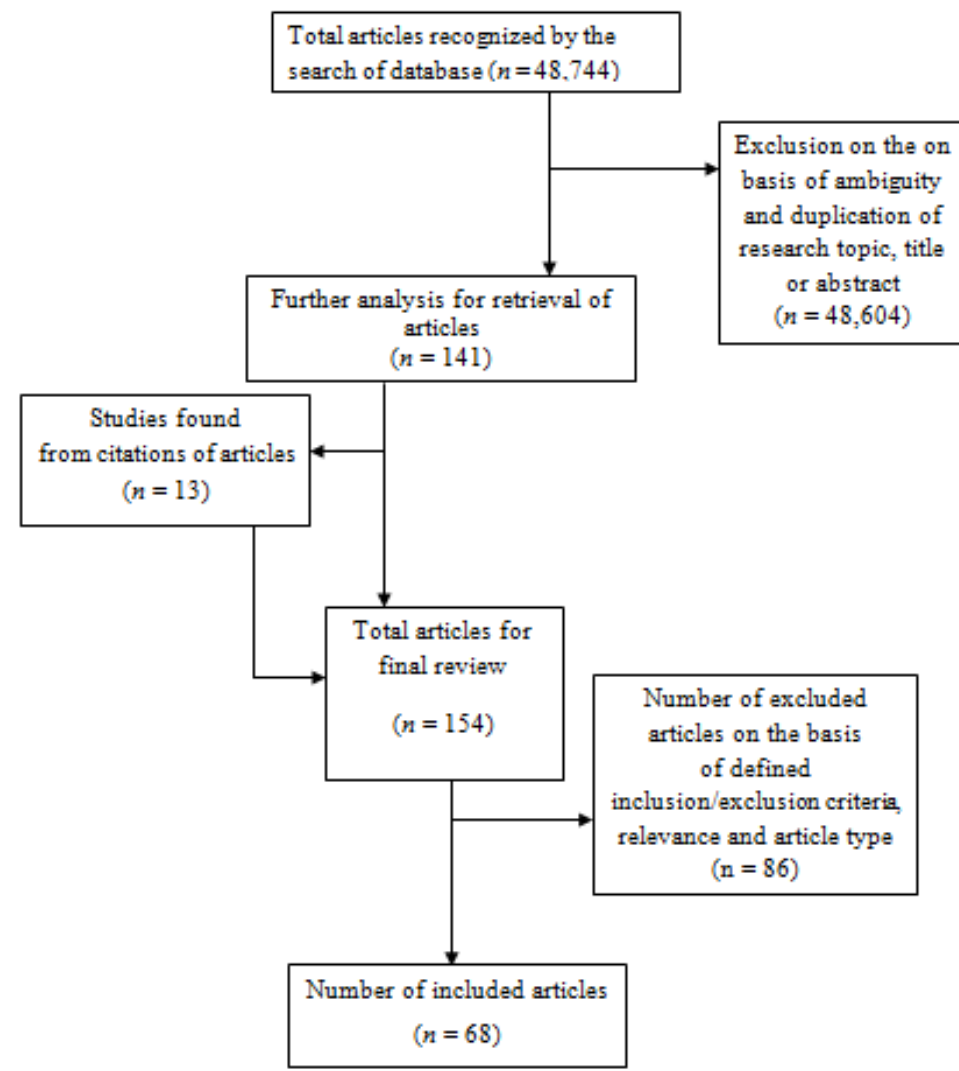
Figure 1. Study selection flow diagram.